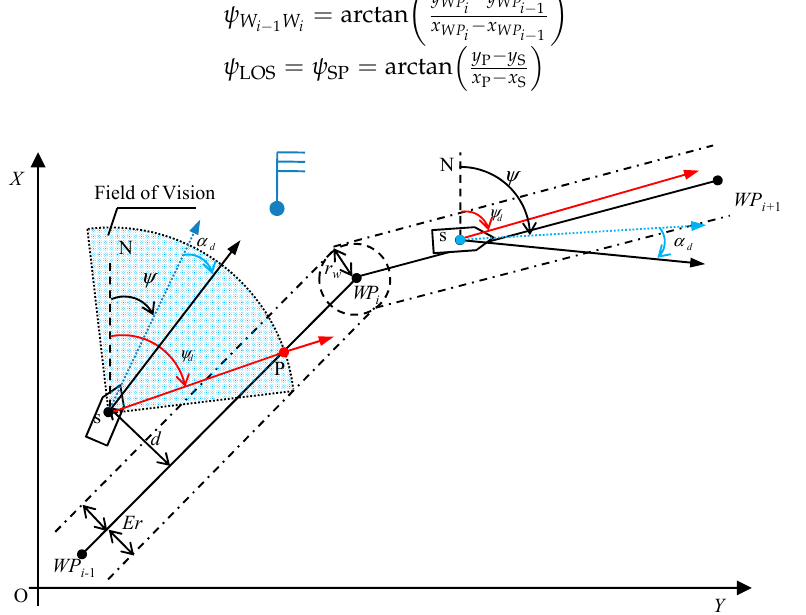
Figure 4. The guidance of improved LOS with course-keeping in track-belt.